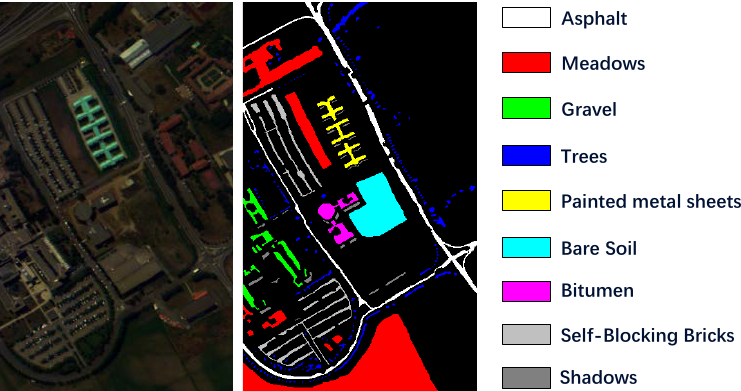
Figure 4. PaviaU dataset description. The false-color image is generated from spectral band 56, 28, 5 and the ground truth map together with the respective classes are displayed.